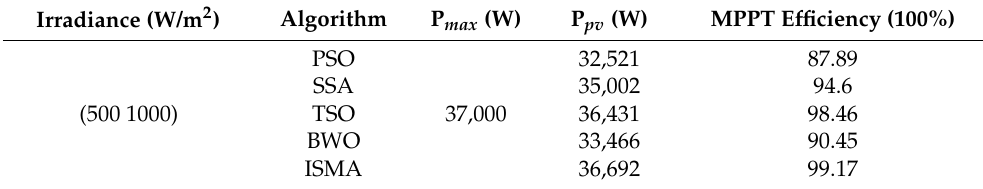
Table 5. Comparison of performance parameters of different control